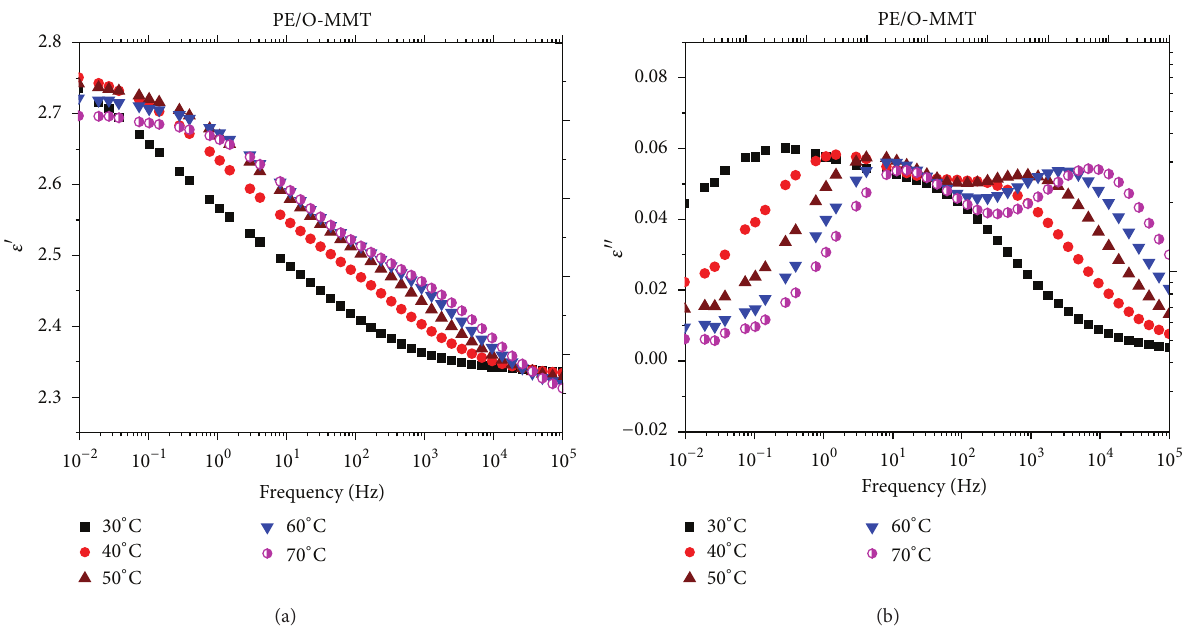
Figure 6: Relative permittivity 𝜀 󸀠 (a) and dielectric loss 𝜀 󸀠󸀠 (b) for PE/O-MMT nanocomposites versus frequency at different temperatures.